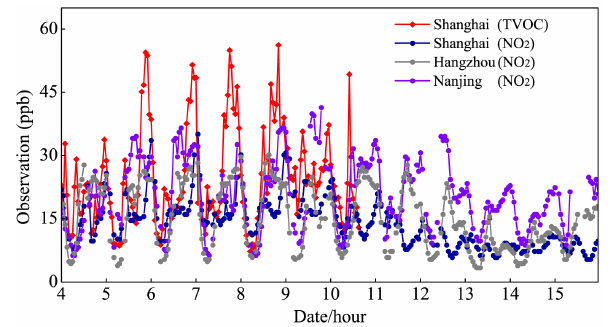
Figure 3. Temporal variations of the observed NO 2 concentrations at Shanghai, Nanjing and Hangzhou stations from 4 to 15 August 2013 and the observed TVOC concentration at SAES (31.17 ◦ N, 121.43 ◦ E) in Shanghai from 4 to 10 August 2013.